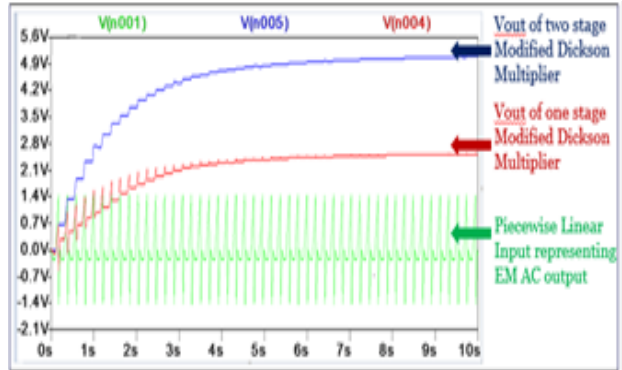
Figure 7. Simulation result for modified Dickson Multiplier